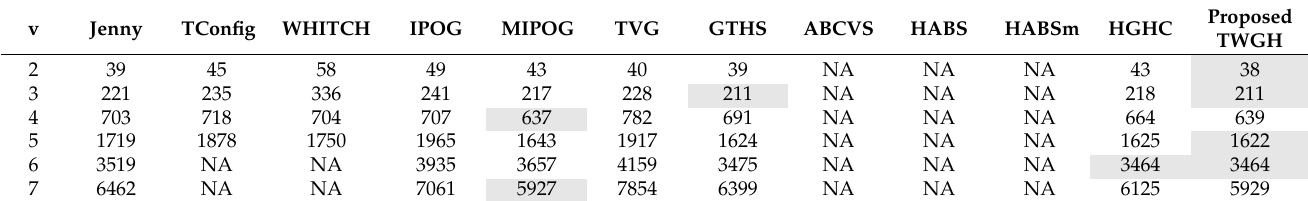
Table 5. CA (N; 4, 10, v) with v varied from 2 to 7.